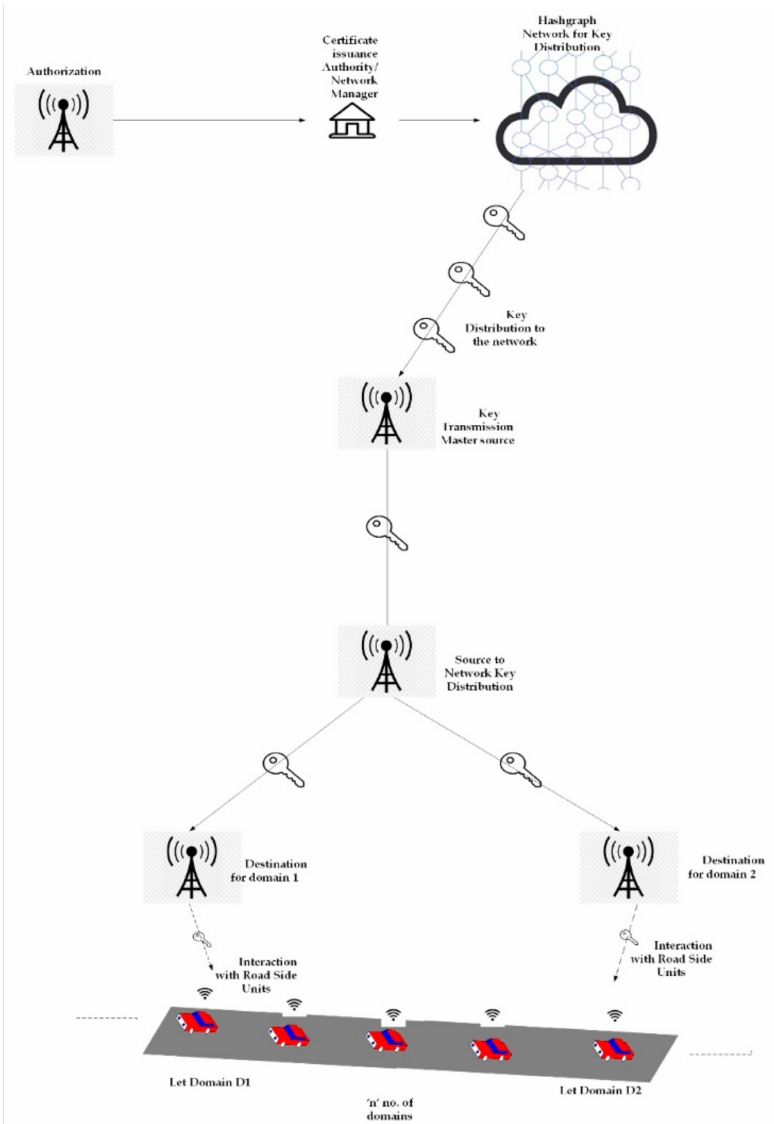
Figure 2. Suggested framework with